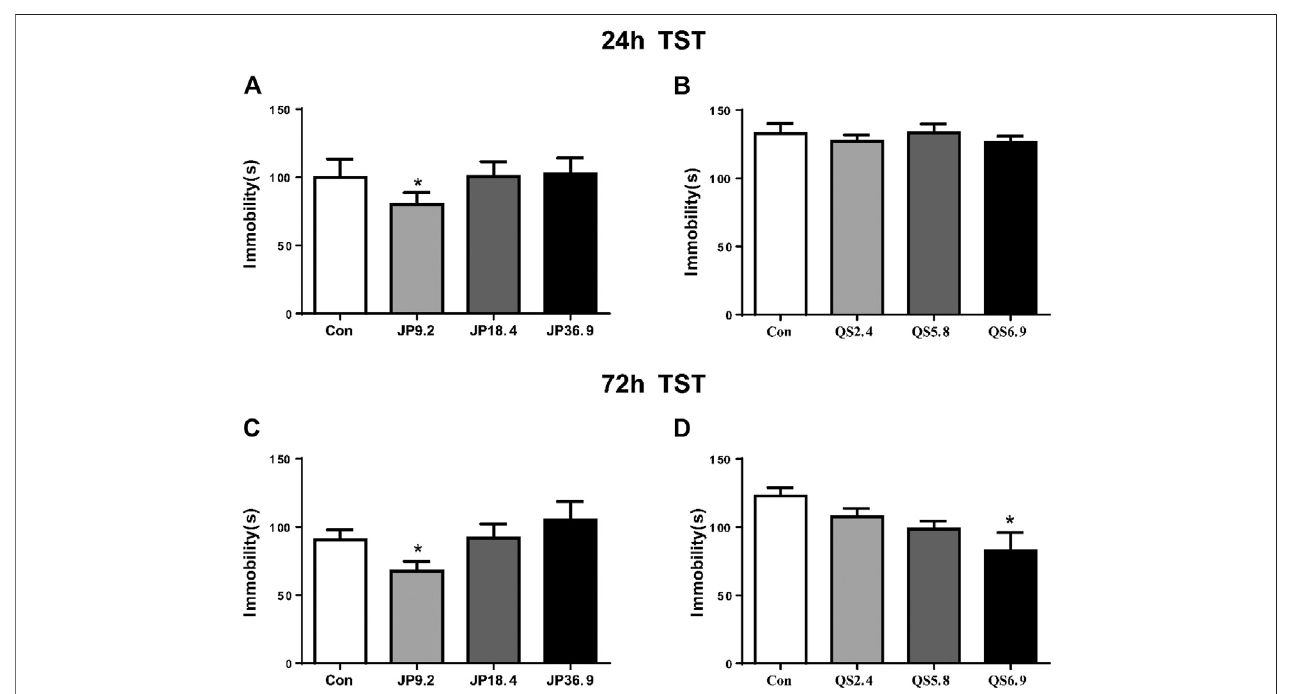
FIGURE 1 | Screen of effective antidepressant dose of JPJY and QS. Control animals (Con) received vehicle treatment, the doses of JPJY with 9.2, 18.4 and QS with2.4,5.8,and 6.9 g/kgwereused fortest. (A) Tailsuspension test wascarriedout at24 hafter JPJY administration. Immobilitytime wasmeasured forthelast4 min during the 6 min testing time [ANOVA, F (3, 37) (cid:2) 3.379, p < 0.05, and n (cid:2) 9 – 12). (B) Tail suspension test at 24 h after QS administration [ANOVA, F (3, 28) (cid:2) 0.3887, p > 0.05, and n (cid:2) 8]. (C) Tail suspension test at 72 h after JPJY administration [ANOVA, F (3, 39) (cid:2) 3.140, p < 0.05, and n (cid:2) 8 – 10]. (D) Tail suspension test at 72 h after QS administration [ANOVA, F (3, 28) (cid:2) 3.975, p < 0.05, and n (cid:2) 8]. Data represent mean ± SEM, * p <